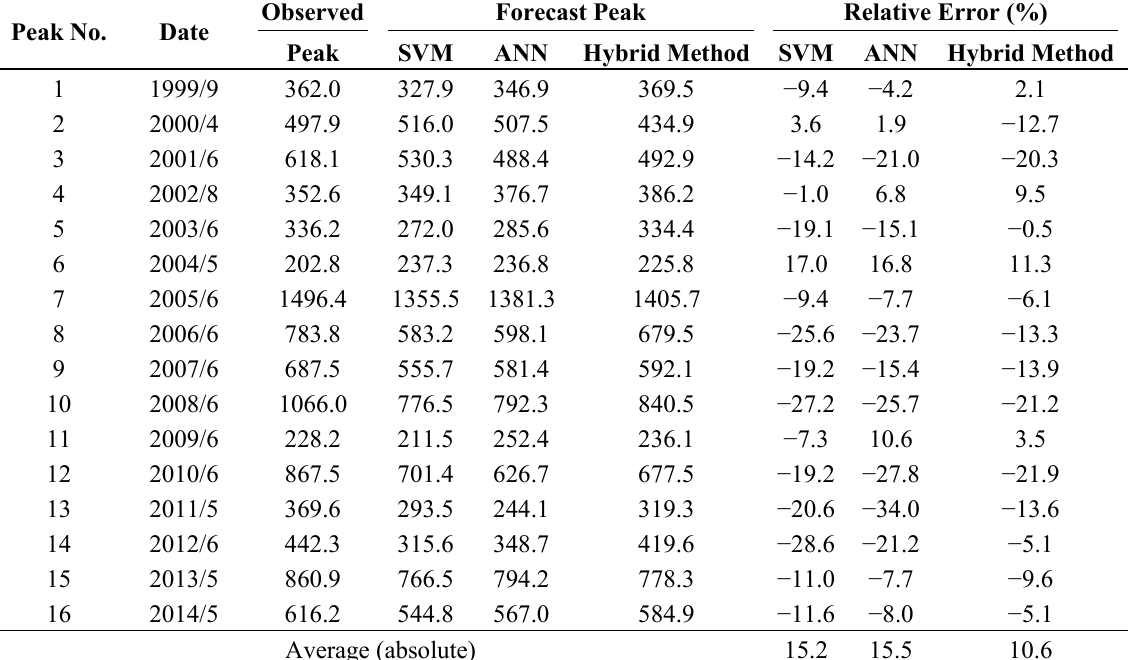
Table 4. Peak flow estimates of three models for Xinfengjiang reservoir during the validation